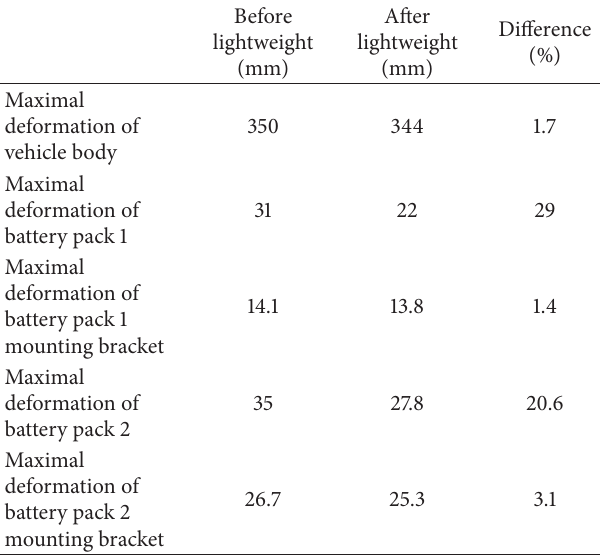
Table 7: The rear-end collision simulation comparison of E-REV before and after lightweighting the main